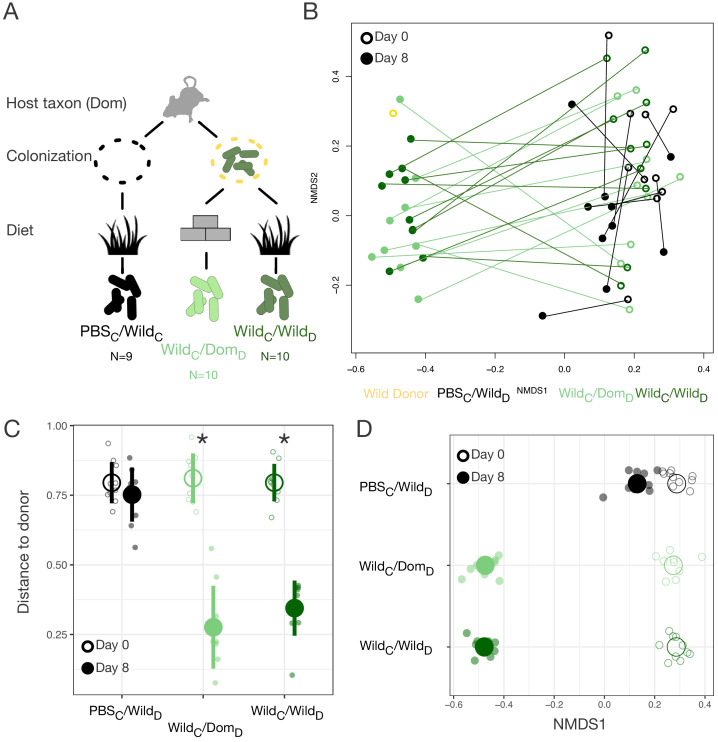
Laboratory mice can be re-wilded through colonization with a wild gut microbial community.(A) Design scheme for colonization/diet mouse experiment (N = 9–10 mice per treatment group). (B) Nonmetric multidimensional scaling (NMDS) ordination of Bray–Curtis dissimilarities showing changes for mice from day 0 (open circles) to day 8 (filled circles) by experimental groups (color). (C, D) At the end of the experiment (filled circle), distance to the wild community donor decreased most in animals colonized with wild communities (p=0.004 WildC/DomD and p=0.002 WildC/WildD, Mann–Whitney U test; C), but all experimental groups exhibited change along Bray–Curtis ordination NMDS axis 1 (p=0.002 PBSC/WildD, p=0.004 WildC/DomD, and p=0.002 WildC/WildD, one-sample Wilcoxon tests; D) during the course of the experiment. * in (C) indicates p<0.05, Mann–Whitney U test comparing day 0 to day 8 for each experimental group. Large circles are means; bars in (C) show standard deviations.